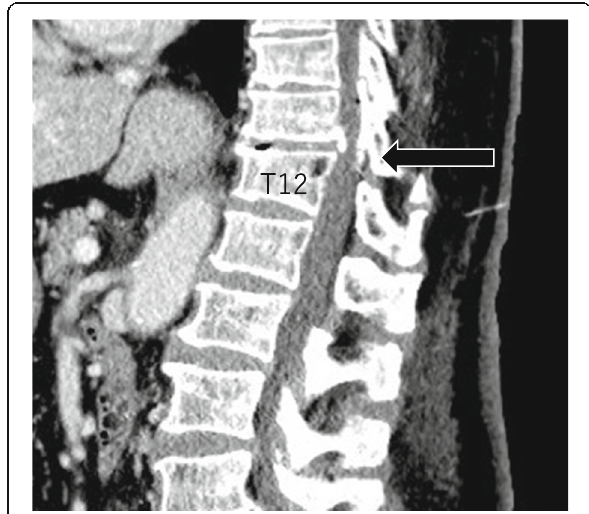
Fig. 2 Sagittal computed tomography (CT) image of the vertebrae. The tip of the epidural tube was present at narrowest area of the spine ( arrow